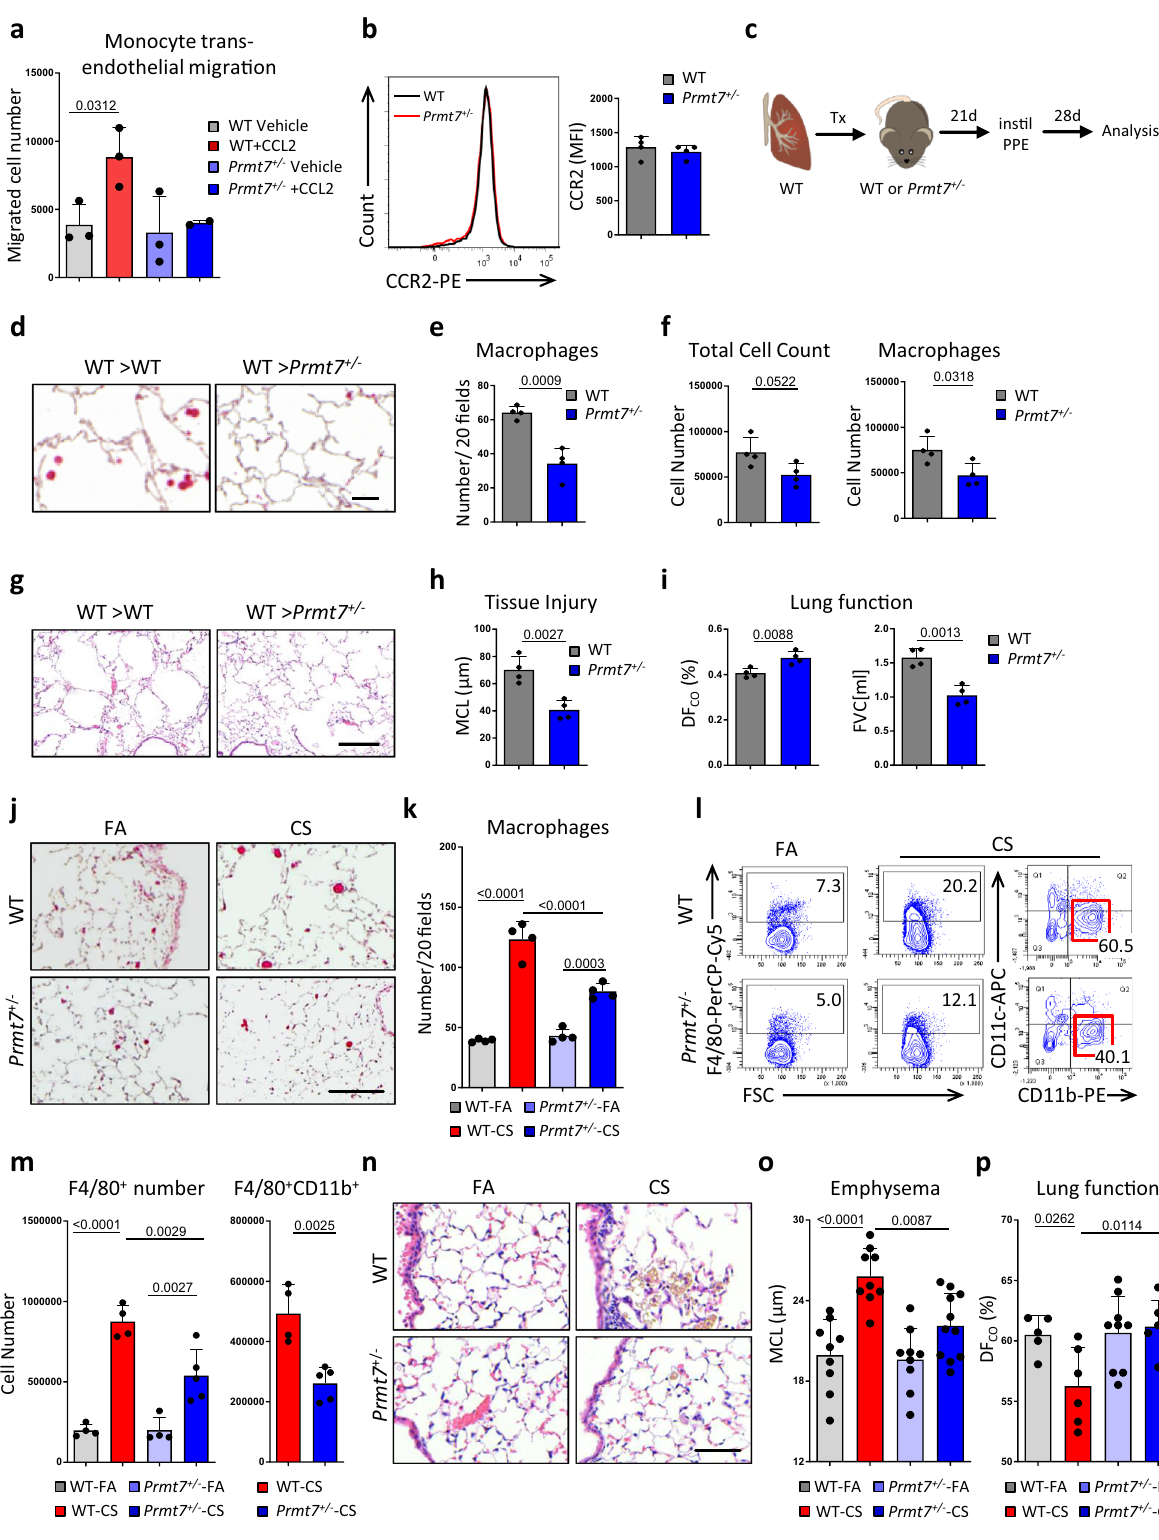
ACSL4 in AT2 cells was crucial for ferroptotic cell death mediated by the GPX4 inhibitor RSL3 55 (Supplementary Fig. 18h), which was prevented in Acsl4 − / − cells (Supplementary Fig. 18h) and reversible by co-treatment with the ferroptosis inhibitor liproxstatin-1 (Supplementary Fig. 18i). Additionally, Prmt7 + / − mice that were protected from emphysema development did not